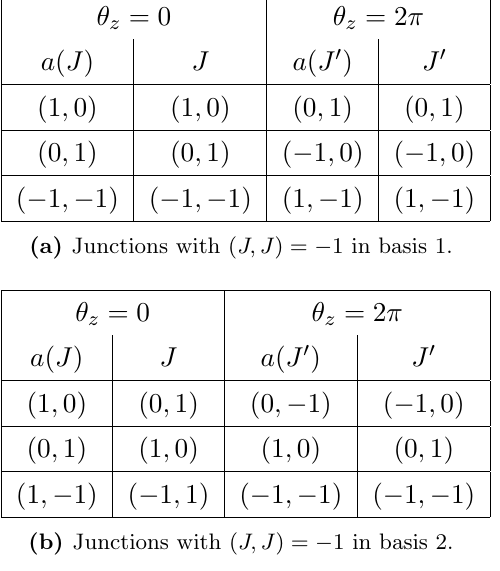
Table 4. Junctions with self-intersection 1 in bases one and two for b = 1 in the g -tube. As can (cid:0) be seen, the sign of the second entry of the junction vector is (cid:13)ipped after the braid action. Let us turn to study the cases associated with di(cid:11)ering values of a . a =